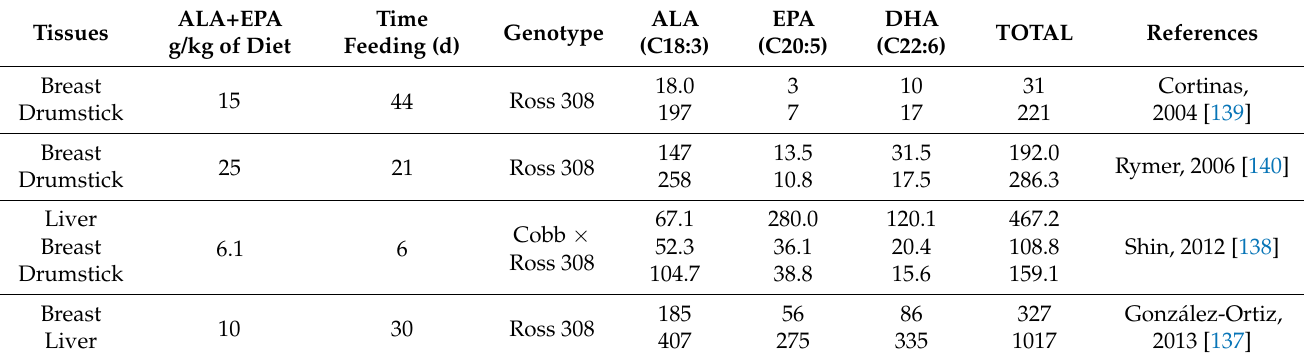
Table 3. n-3 fatty acid profile (mg/100 g of fresh tissue) in liver, breast, and drumstick tissues of broilers fed with different ALA and EPA